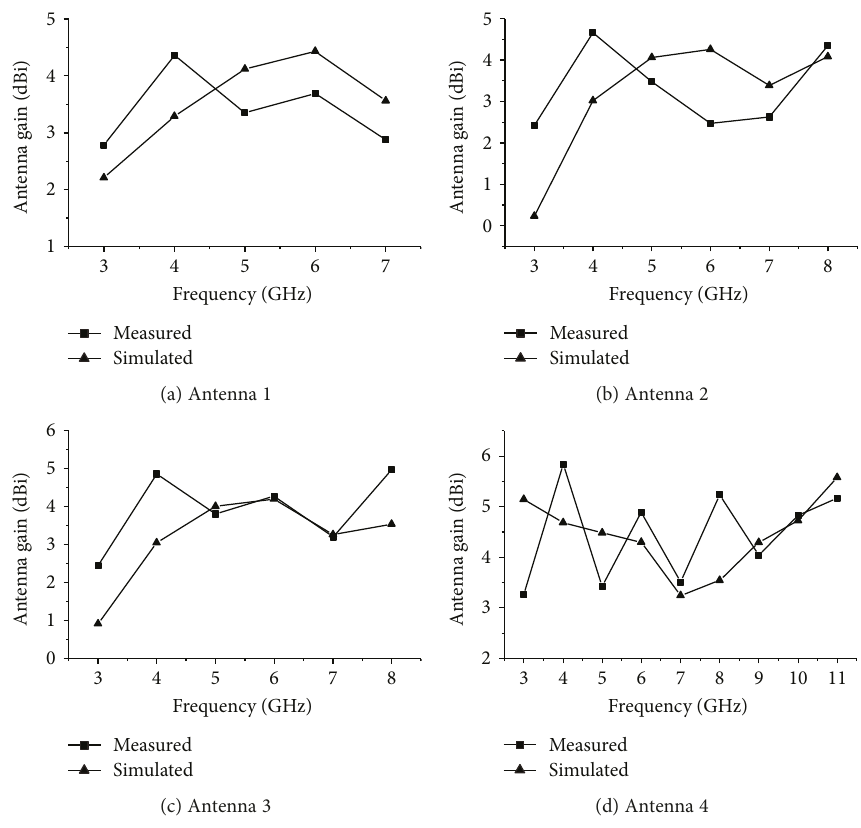
Figure 13: Antenna